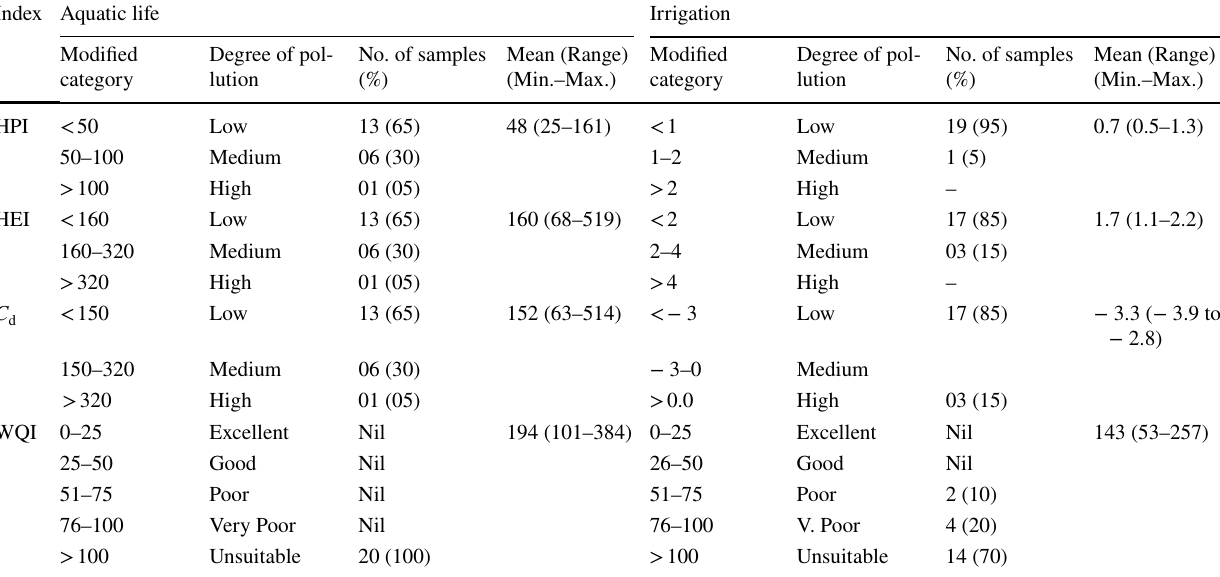
Table 2 Classification of water in Bhindawas wetland based on HPI, HEI, degree of contamination and WQI Index Aquatic